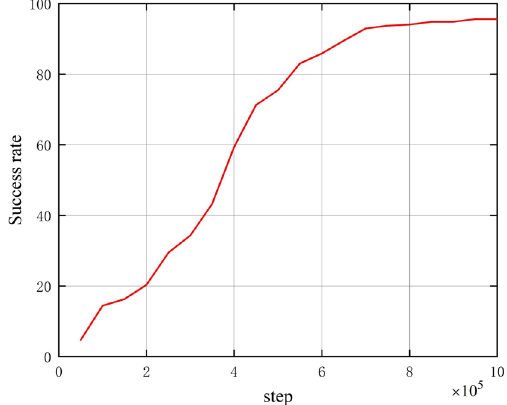
Figure 15. The success rate of the robot in completing the task.